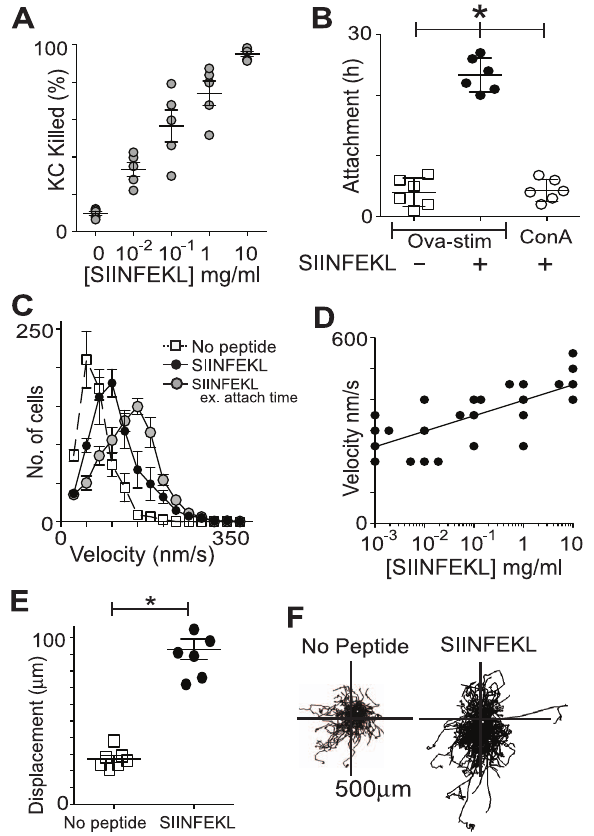
Figure 5. KC killing is dependent on antigen presentation and T cell activity. A . Antigen-specific CTL were co-cultured with B6 KC loaded with increasing concentrations of SIINFEKL peptide. Percentage of total KC killed during of imaging 30 hours was measured by fluormetric detection of caspase-3 activation. (N=5, error bars SEM). B . Average duration of attachments of activated T cells, either antigen specific Ova-stim CTL or non-specifically activated ConA CTL, to targets with or without peptide. (N=6, error bars SEM). C . Velocities of antigen- specific CTL added to target KC, with and without peptide loading, were calculated from 30 h tracks. Values were binned 25 nm.s 2 1 and averages of 5 experiments are shown. Error bars are SEM. D . Examination of the velocities of the effector T cells (from (A)) in response to different concentrations of peptide loaded onto target cells. Linear regression line shown. E . Average displacements of CTL in the presence or absence of cognate antigen. (N=5, error bars SEM) F . Example of actual tracks of CTL cultured with target cells, with and without peptide, translated to a common starting point. (*p , 0.05, *p , 0.05 between indicated groups